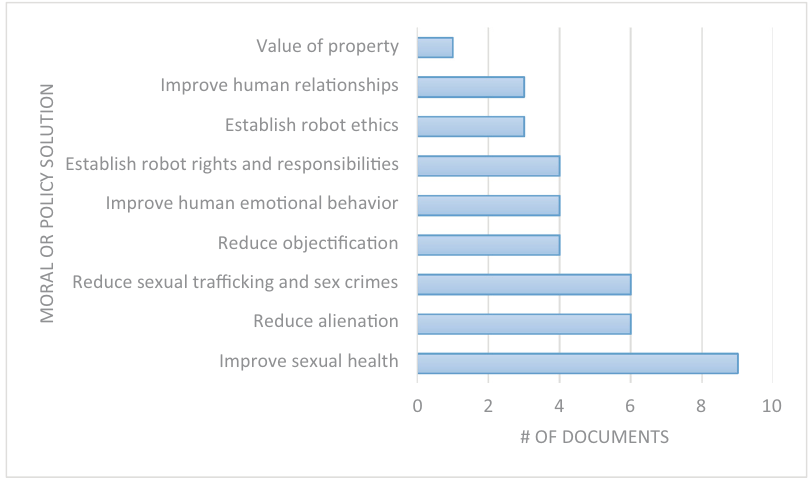
Figure 7: Sex robot - coded moral or policy solution frequency ( Scopus ) .